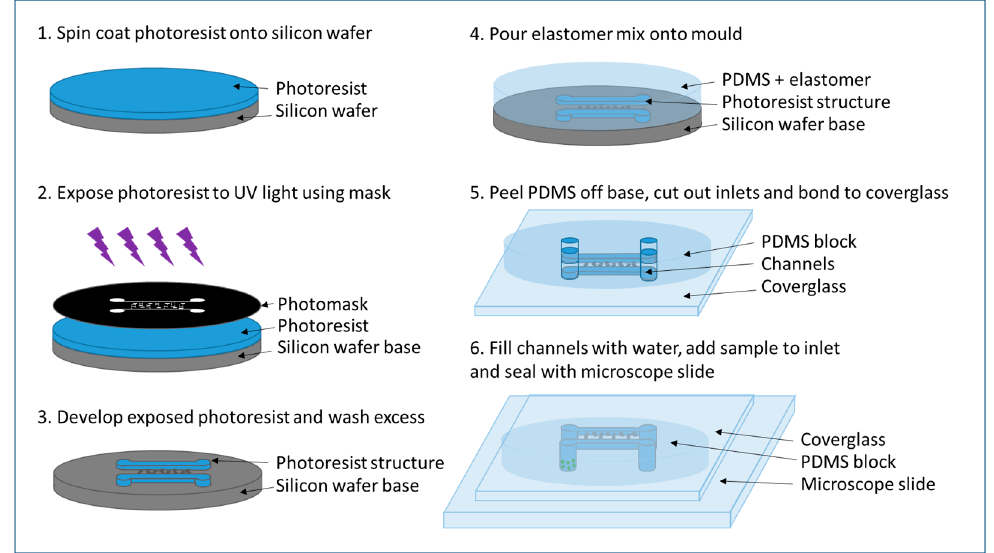
Figure 4. Soft lithography process for making PDMS devices.